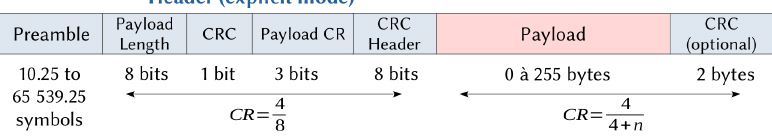
Figure 6. LoRa Physical Protocol Data Unit.